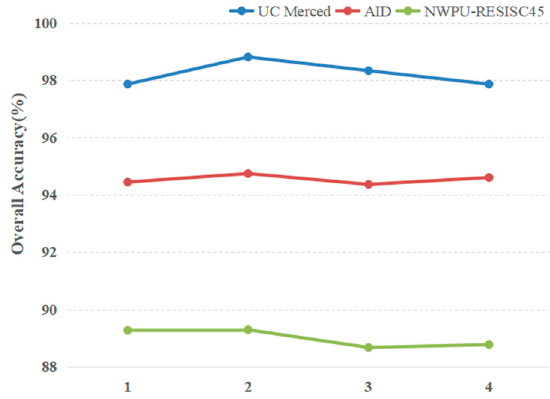
Figure 12. The influence of the routing number on the classification accuracy.